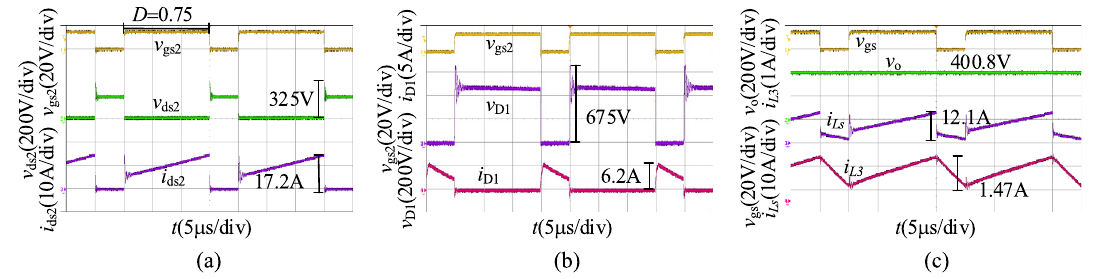
Figure 19. The experiment results of the proposed converter in the step-up mode when v 2 = 48 V: ( a ) v gs2 , v ds2 , i